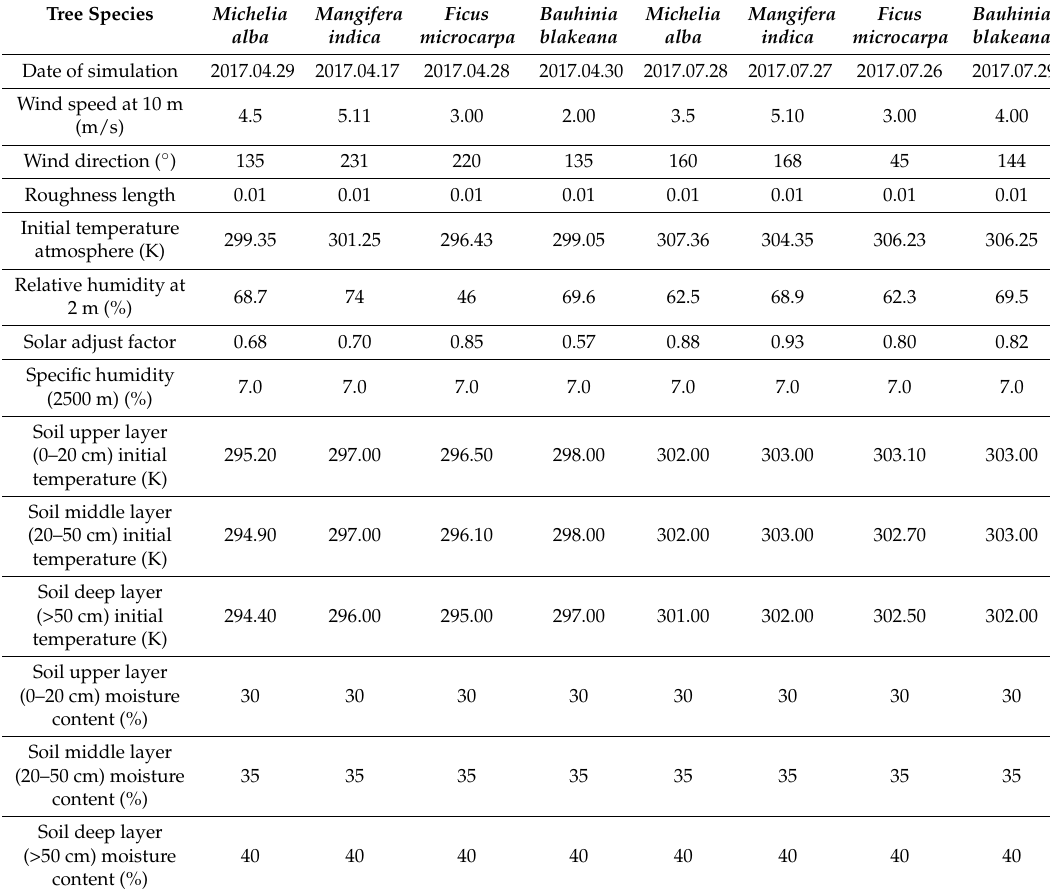
Table 3. Inputs of background meteorological